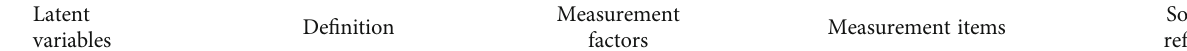
Table 1: Explanation and source of research